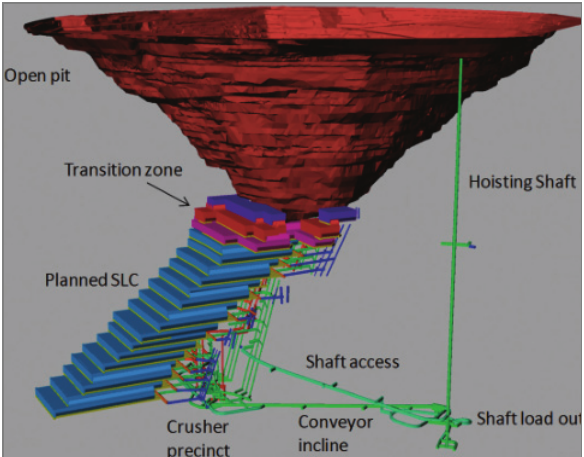
Fig. 5. Three dimensional view of the sublevel cave and final pit at the Ernest Henry mine (Campbell et al. [5])